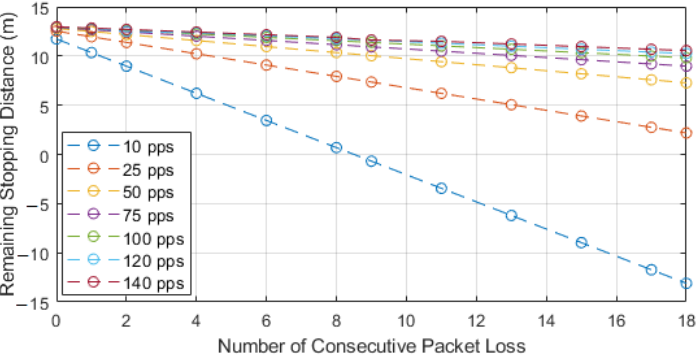
Figure 4. Thirty miles per hour (48.27 km/h) reduction in stopping distance.